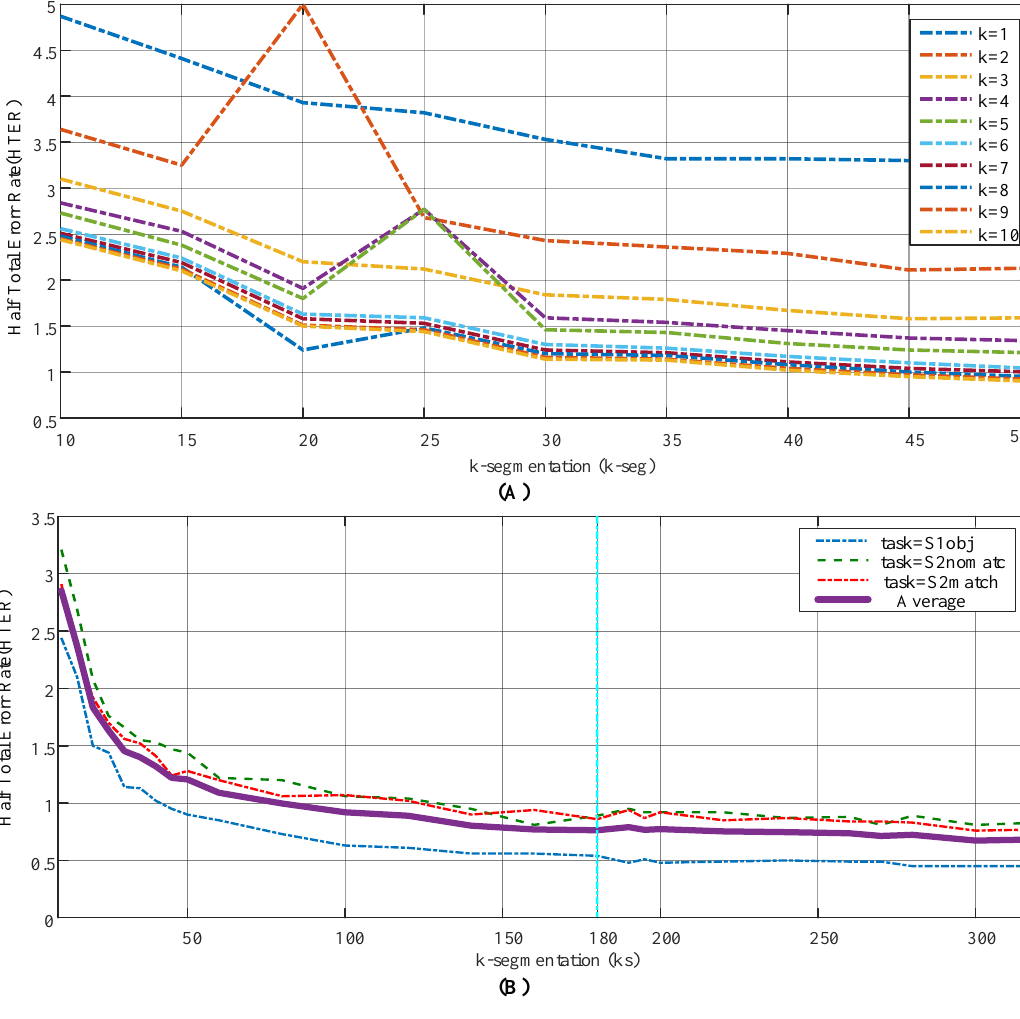
Figure 7. HTER diagram in terms of different k_seg values for different k values, 18-channel system (A) The HTER diagram in terms k_seg for the 18-channel system and k = 10 (B)